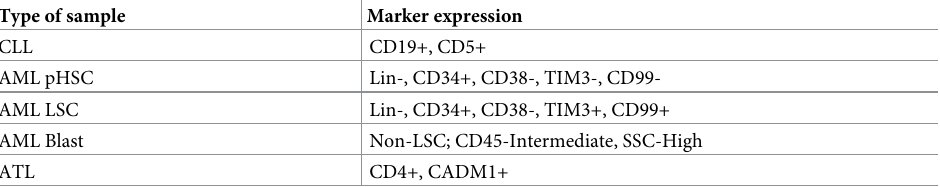
Table 2. Immunophenotypes of leukemic samples. Immunophenotype of CLL [8]: Note that B cells are CD19+, as shown in Table 1. Immunophenotype of AML [7]: SSC-high means that the intensity of side scatter in the flow cytome- try is high. Note that HSC, MPP, and LMPP are Lin-, CD34+, CD38- as shown in Table 1. Immunophenotype of ATL [24, 25]: Note that CD4 + T cells are CD4+, as shown in Table